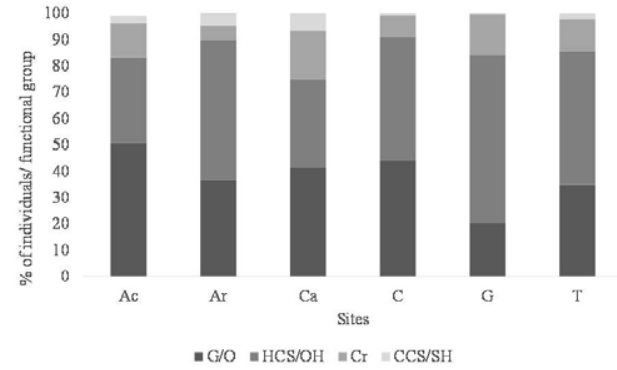
Fig 1. Percentage of ants per functional group. Ac – Aciprestes; Ar – Arnozelo; Ca – Carvalhas; C – Cidrô; G – Granja; T – all sites combined; G/O - generalists and/ or opportunistic; HCS/OH - hot climate specialists and/or open habitats; Cr - cryptics; CCS/SH - cold climate specialists and/or shade habitats.